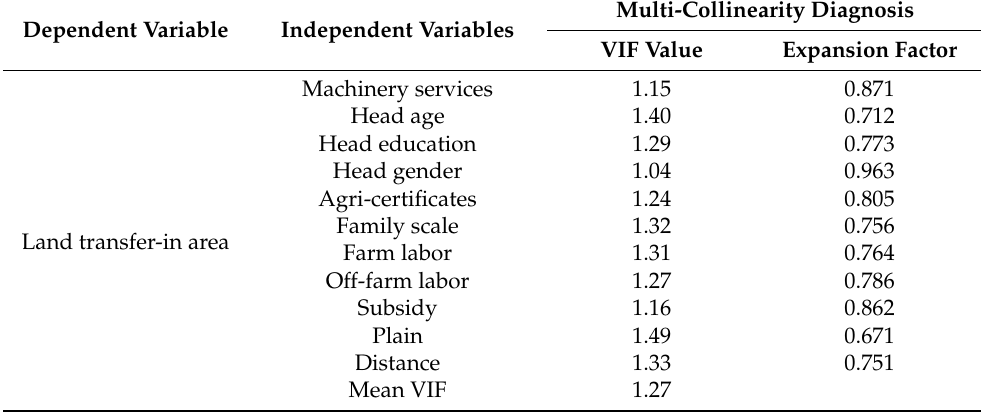
Table 2. Results of multicollinearity